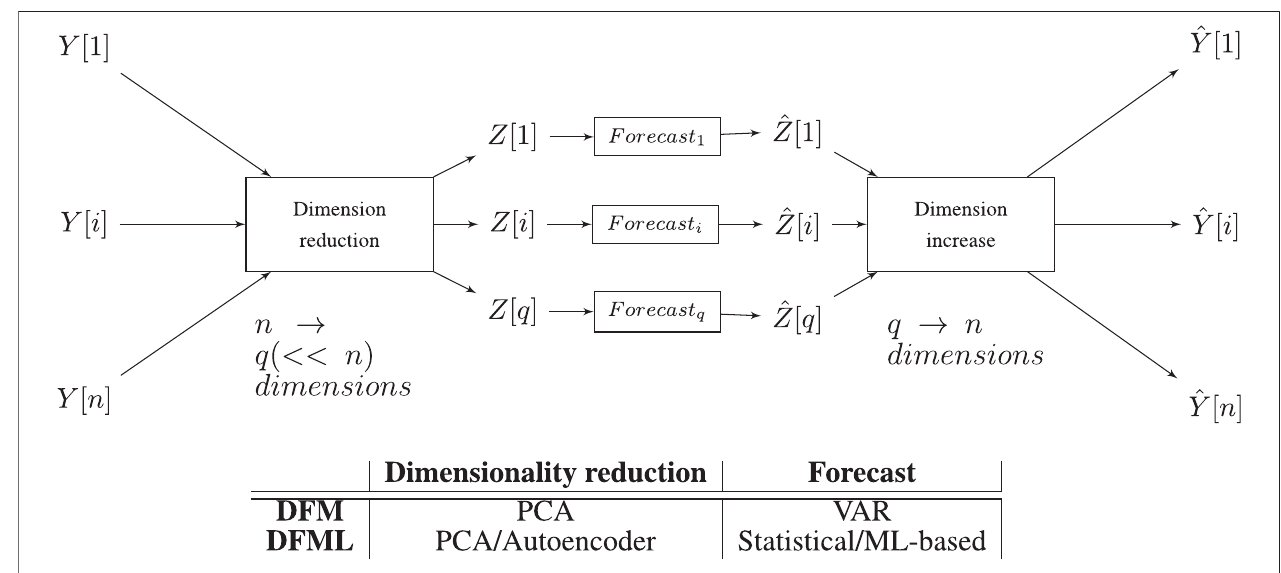
FIGURE 2 | Schema of the DFML architecture with a table summarizing the different components as implemented in the different methods.